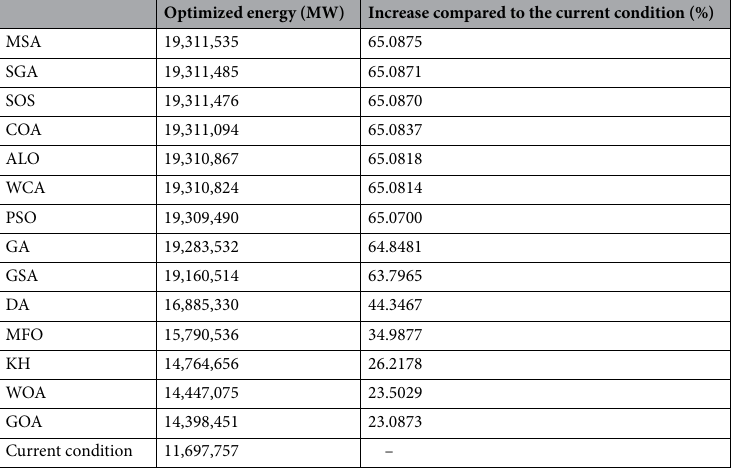
Table 5. The optimized values of energy generation vs. the current condition.